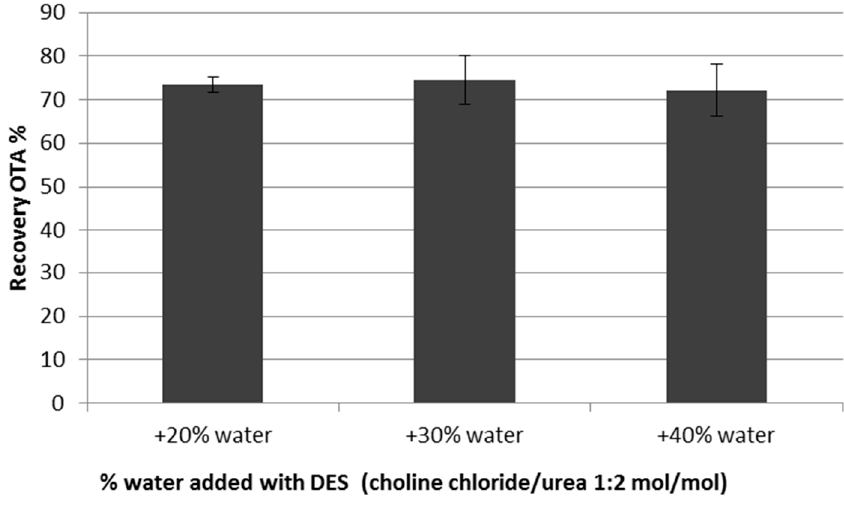
Figure 3. Percentage recoveries of OTA from spiked wheat using DES containing increasing percentages of water as extraction media.